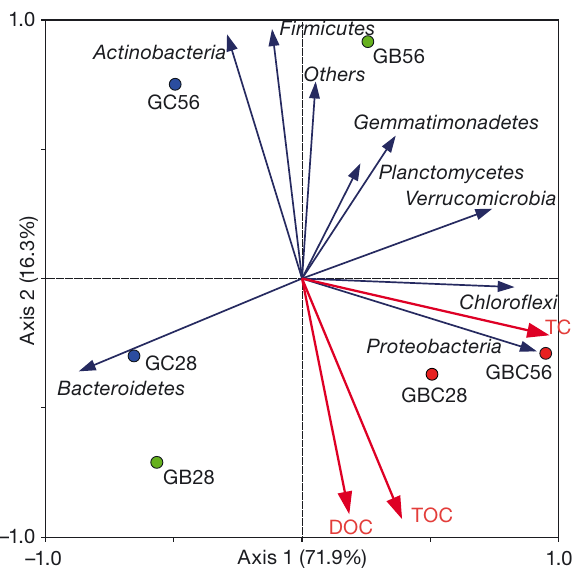
Fig. 8. Redundancy analysis of bacterial community struc- ture and carbon content on Days 28 and 56. Labels represent treatment and day combinations (see Fig. 6); DOC: dissolved organic carbon; TOC: total organic carbon; TC: total